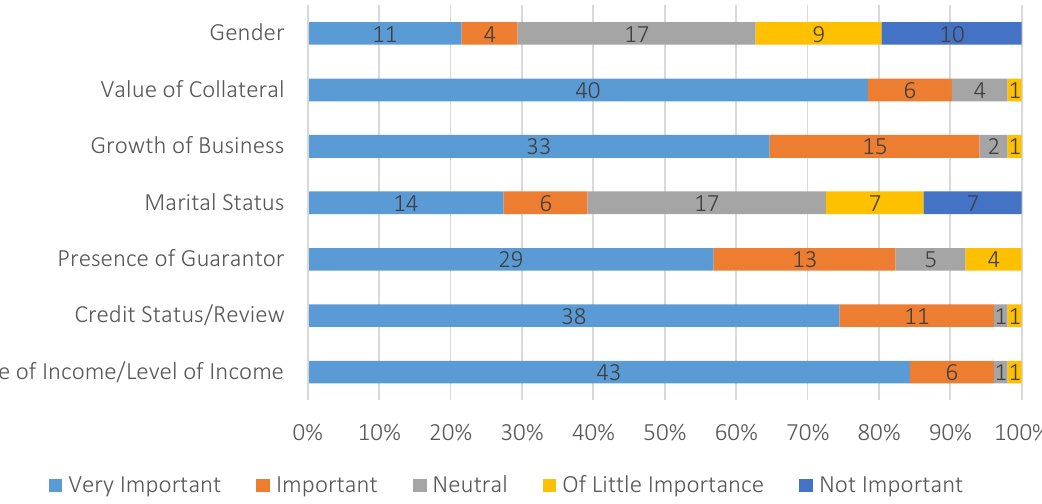
Figure 3. Criteria to access building credits across different